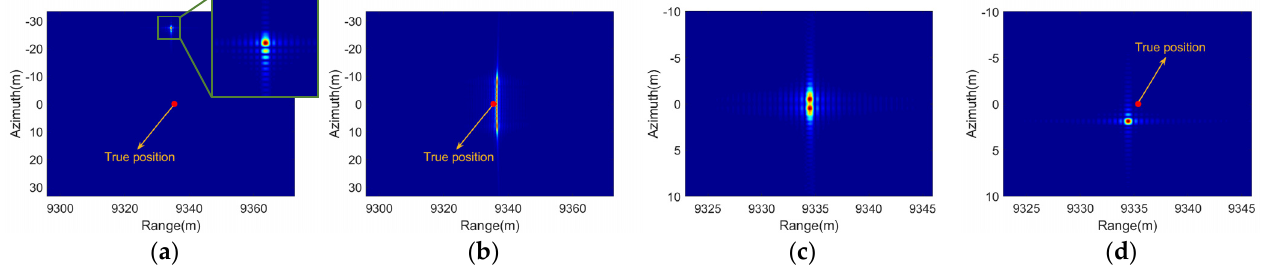
Figure 11. Focusing results of point target with linear oscillations. ( a ) Target oscillates along the range direction, ϕ l = 0; ( b ) target oscillates along the range direction, ϕ l = π / 2; ( c ) target oscillates along the azimuth direction, ϕ l = 0; ( d ) target oscillates along the azimuth direction, ϕ l = π / 2. The red dot represents the true position of the target.